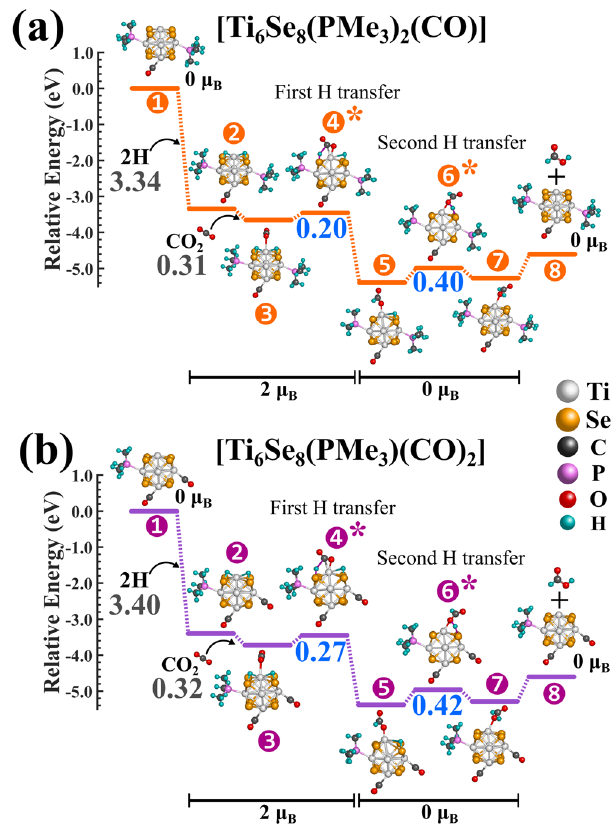
Fig. 4 CO 2 → HCOOH conversion on the [Ti 6 Se 8 (PMe 3 ) 3-m (CO) m ] (m = 1,2) clusters. The most favorable CO 2 → HCOOH conversion pathways on the ( a ) Ti 6 Se 8 (PMe 3 ) 2 (CO) and b Ti 6 Se 8 (PMe 3 )(CO) 2 clusters. The binding energies of H and CO 2 are shown in grey, barrier heights are shown in blue color. The transition states are marked with asterisk (*) symbol.